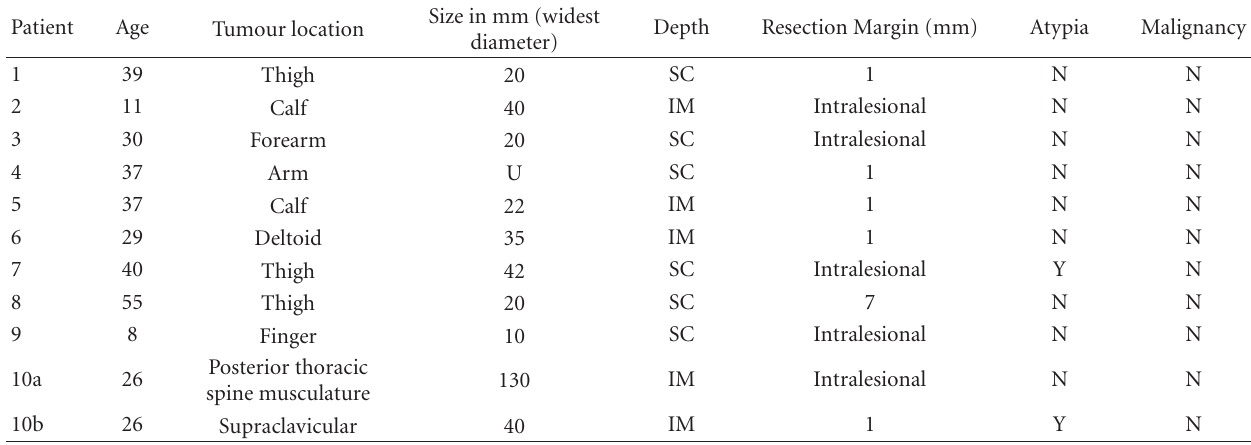
Table 1: Patient data and histological features a